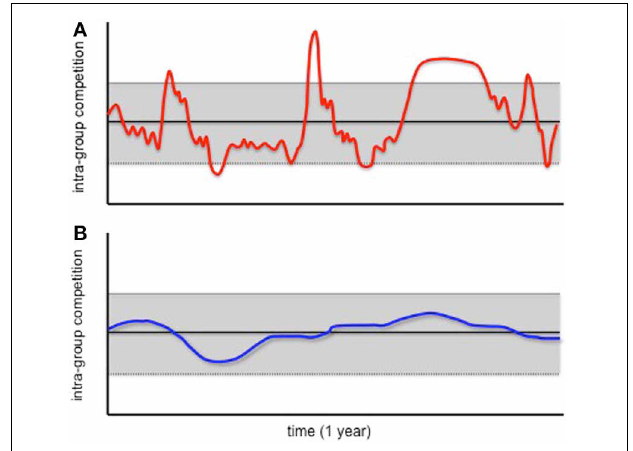
FIGURE 1 | Levels of intra-group competiton within hypothetical primate groups. One group has highly variable levels of intra-group competetion over the period of 1 year (A) , the other has relatively invariable levels (B) . Black lines indicate mean intra- group competition levels, while gray bars indicate one standard deviation above and below the